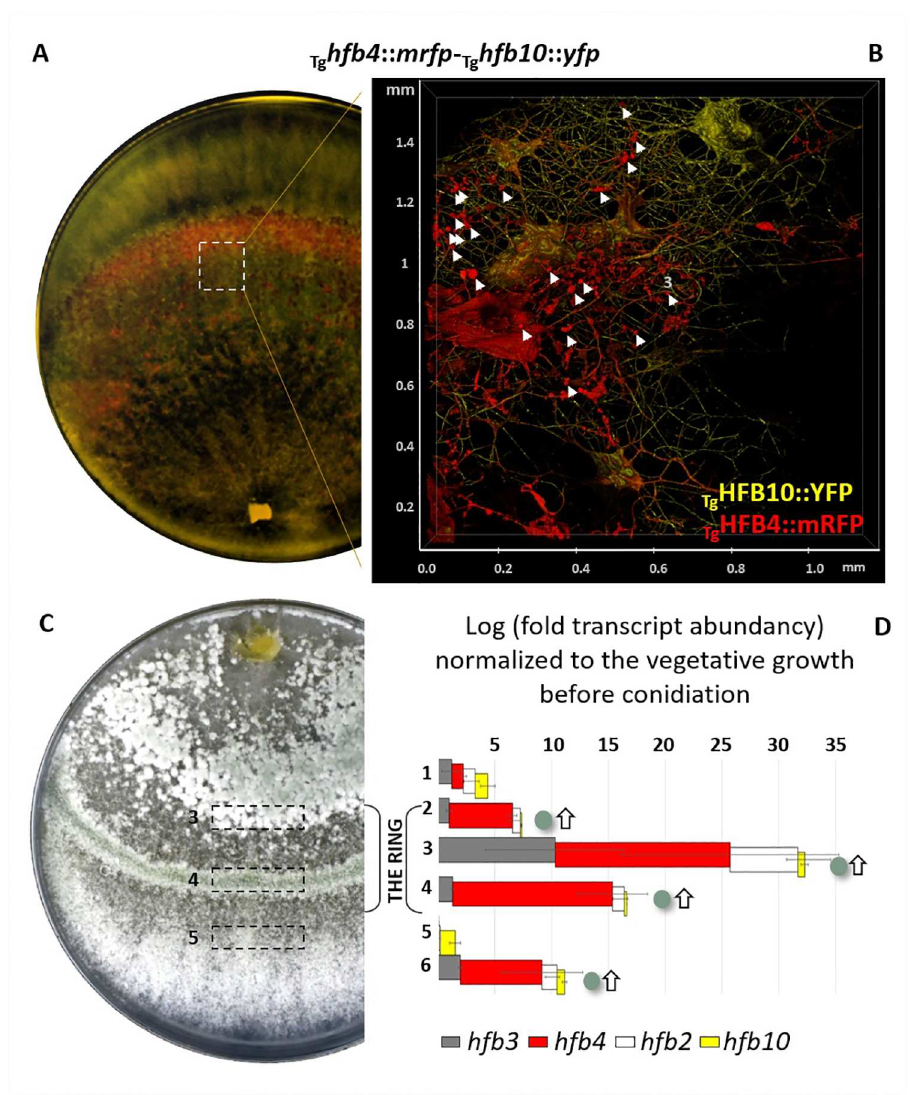
Fig 5. Colony architecture and dynamic HFB accumulation in aerial hyphae before and during conidiogenesis. (A) Fluorescent imaging of early conidiating T . guizhouense colony (48 hours) with mRFP- and YFP-labeled HFB4 and HFB10, respectively. The time course images of Tg and Th observed in ChemiDoc are shown in S17 Fig. (B) A 3D reconstruction of the same colony under epifluorescent microscope. Arrows point to the conidiophores with spore clumps. S3 Video shows detailed 3D animations of the extracellular matrices for both species. (C) A colony of T . guizhouense forming the sporulating ring after 96 hours of incubation. (D) Relative expression of hfb s during the fine time course of conidiogenesis (stages 1 to 6 correspond to the hyphal growth without conidia as 1, early compact pustula formation as 2, appearance of the conidial ring as 3 and 4, the vegetative growth beyond the conidial ring as 5, and dispersed conidiogenesis as 6, also see S18 Fig the boxed areas in C ) of Tg quantified by qPCR. The values are normalized to those of the housekeeping gene tef1 and calculated in relation to aerial hyphae prior to conidiogenesis (stage 1). Horizontal bars indicate standard deviations. Green dots and white arrows right to the bars indicate spores and conidiophores appearing stages, respectively. Complementary results for Th are provided in S18